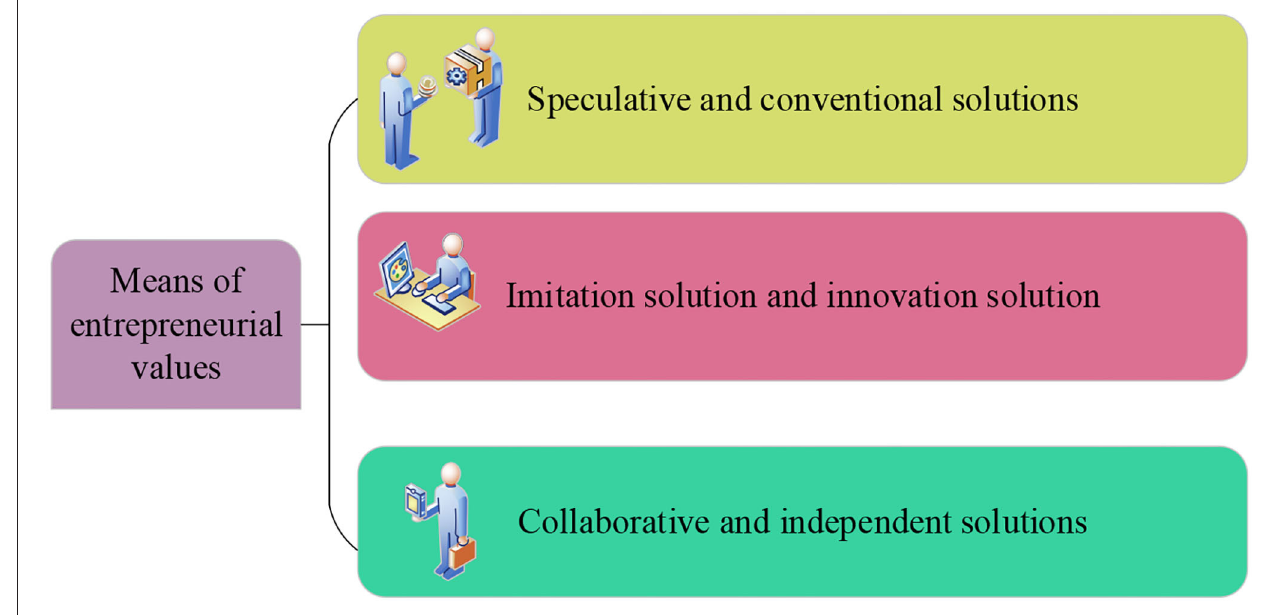
FIGURE 4 | The means of entrepreneurship values of college